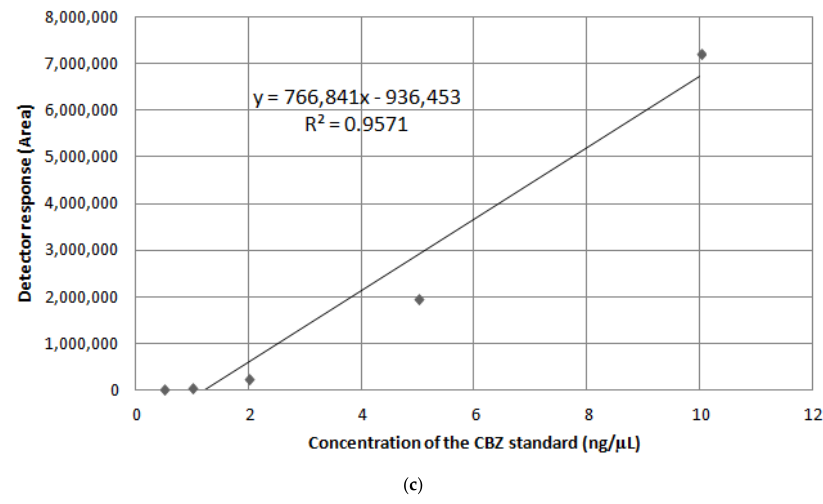
Figure 1. Calibration curve by GC-MS for ( a ) caffeine (CAF), ( b ) benzophenone-3 (BP-3), and ( c ) carbamazepine (CBZ).